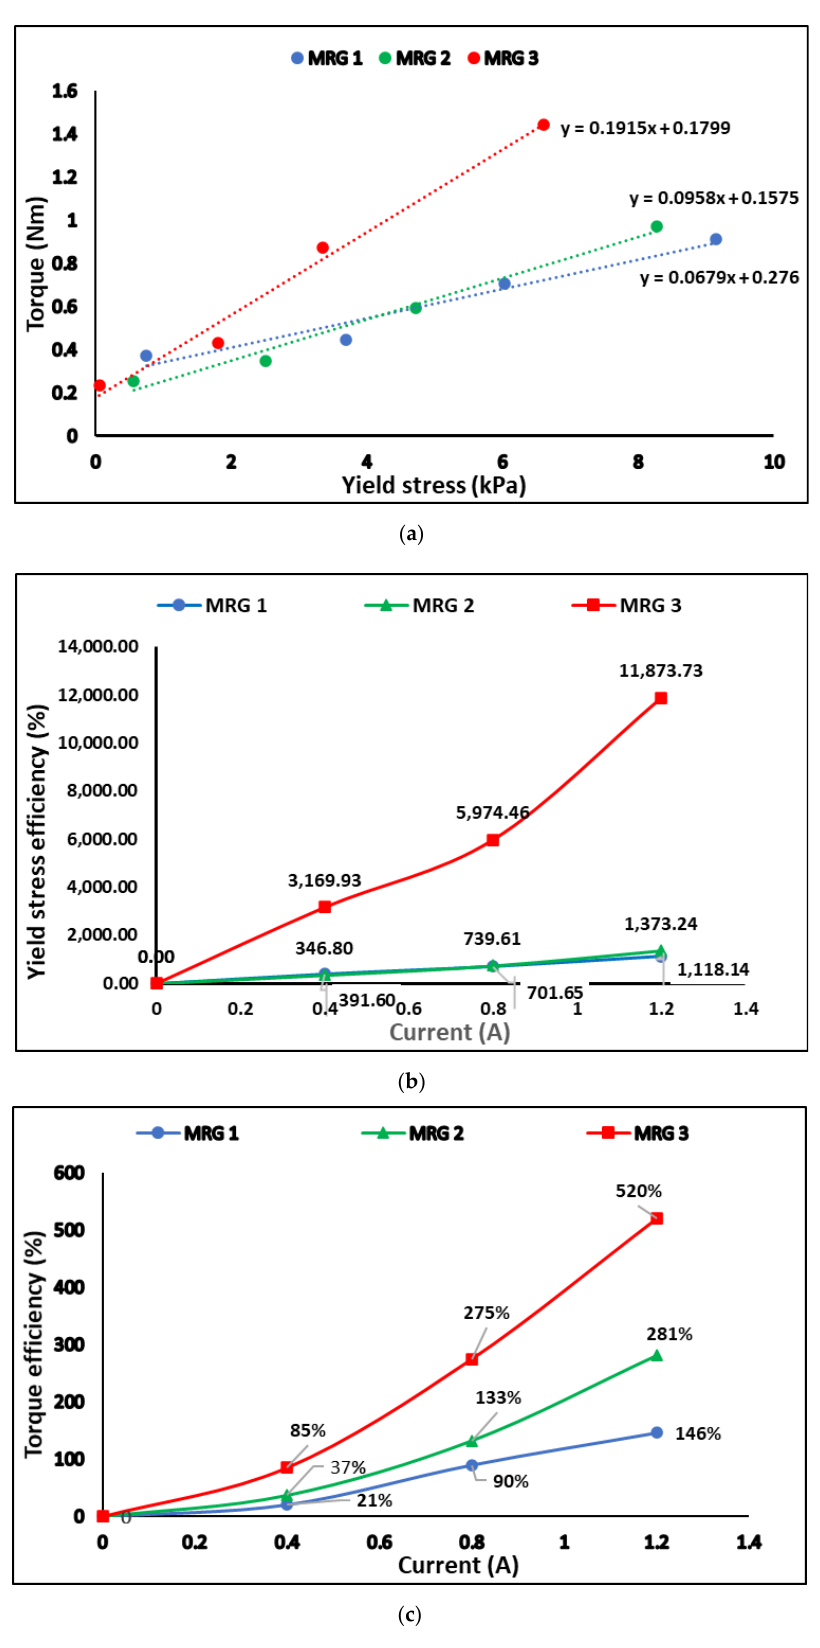
Figure 11. ( a ) The relationship between the yield stress of MRG and their braking torque and the percentage of the increment ( b ) yield stress of MRG and ( c ) braking torque of MRG. Figure 11a showed that the yield stress of MRG has affected the torque performance of MRG in MR brake. In the off-state condition, MRG 3 has the lowest yield stress and generate the lowest braking torque performance followed by MRG 2 and MRG 1 in as- cending order. It was predicted since MRG 1 had the maximum mechanical friction, in- cluding MRG with the MR brake ’ s inner surface, CIP-CIP, and CIP-grease. In general, mechanical friction between MRG and the MR brake ’ s inner housing and rotor has im- pacted the torque of the MR brake in off-state condition. The torque was increased due to the resistance of carrier fluid that flows in grease medium, which restricted the rotation of the shaft [45,46]. At the same time, the viscous friction between the MRG and MR brake also occurred. The rotation of the MR brake has increased the shear stress in carrier fluid and forced the CIP to move in the grease, subsequently, increased the collision between CIPs and CIP with grease medium. Expectedly, the addition of oil resulting on improving the lubrication of the MRG by reducing the mechanical friction. Aside from that, MRG with oil addition produced greater torque performance than MRG 1 with yield stress in- crease. The efficiency of the yield stress and braking torque of MRG can be observed in Fig- ure 11b,c. MRG 3 ’ s yield stress efficiency has grown 3170%, while torque efficiency has increased 85% at 0.4 A. Both yield stress and torque efficiencies were much greater com- pared to MRG 1, which only generated 21% of the torque increment with 392% of yield stress. However, MRG 2 with dilution of hydraulic oil can generated 37% of torque effi- ciency which is higher compared to MRG 1 when the yield stress efficiency of MRG 2 increased to 347%. At 0.8 A, the torque produced by MRG 3 was 275% and the yield stress performance increased to 5974%. As the current increased, the performance disparity be- tween all samples widened. For MRG 2, the yield stress increased up to 740% and the braking torque has increased almost 133%. Meanwhile, MRG 1 with high viscous proper- ties has the lowest yield stress efficiency; 90% and torque efficiency; 702%. A similar phe- nomenon also observed at current applied of 1.2 A. The trend of yield stress and braking torque efficiency of MRG 3 was higher than MRG 2 and MRG 1. The great improvement of yield stress and torque performance of MRG 3 owing to viscous and friction properties on the application of magnetic field. As the magnetic field was applied, the CIP combine to form chain structures aligned with the magnetic flux direction. The bond strength of